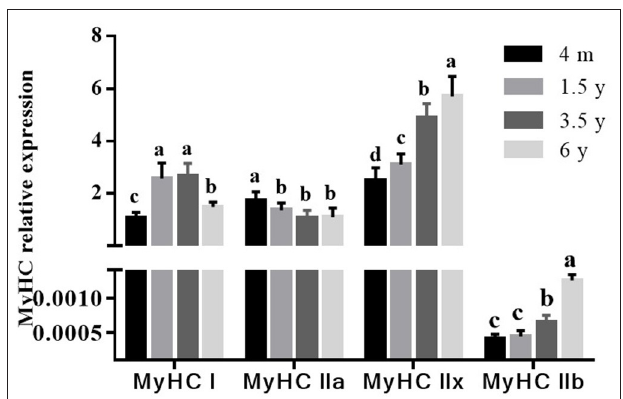
FIGURE 3 | Effect of slaughter age on muscle fiber type-related gene expressions in Tibetan sheep. The mRNA levels were measured by real-time quantitative PCR. The MyHC I, MyHC IIa, MyHC IIx, and MyHC IIb mRNA levels were normalized to the amount of GAPDH mRNA. Data are shown as the means ± S.E. Different letters (a–d) indicate significant differences between different slaughter age ( p <